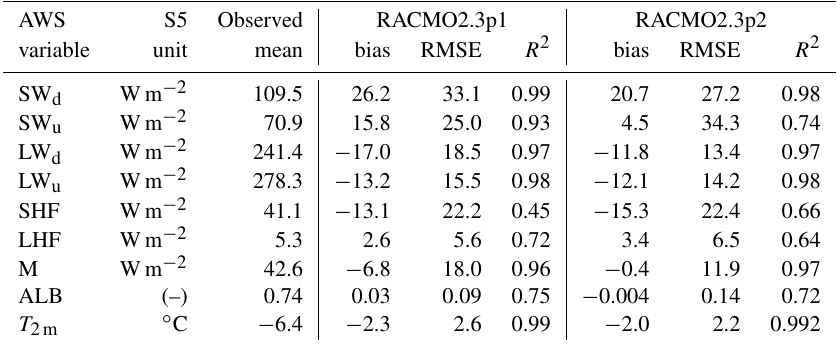
Table 2. Modelled and observed mean SEB components and statistics of the differences (2004–2015) at station S5 in the lower ablation zone (490ma.s.l.). Statistics include means of measurements collected at S5, model bias (RACMO2.3pX – observations), RMSE of the bias as well as the determination coefficient of monthly mean data. All fluxes are set to positive.